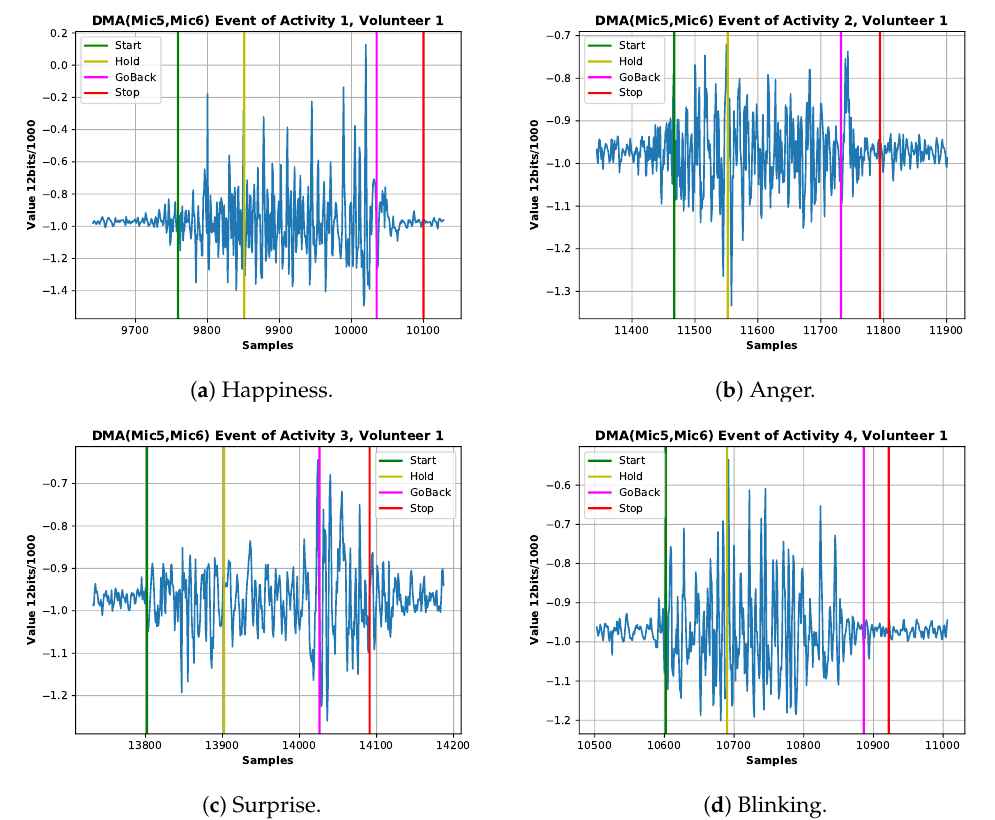
Figure 6. Example ADC coded signal of four expressions from the best volunteer. ( a ) Happiness signal of the first session signaling start,holding,go-back and stopping gesture. ( b ) Anger signal of the first session signaling start, holding, go-back and stopping gesture. ( c ) Surprise signal of the first session signaling start, holding, go-back and stopping gesture. ( d ) Blinking signal of the first session signaling start, holding, go-back and stopping